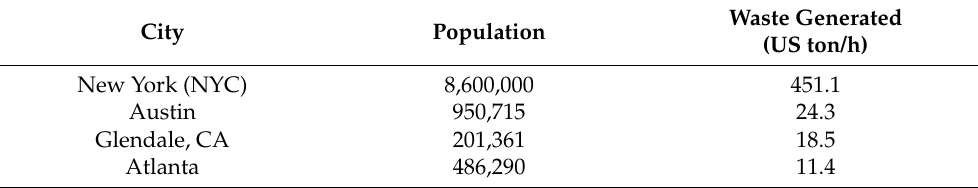
Table 10. The cities with their respective population and waste generation.